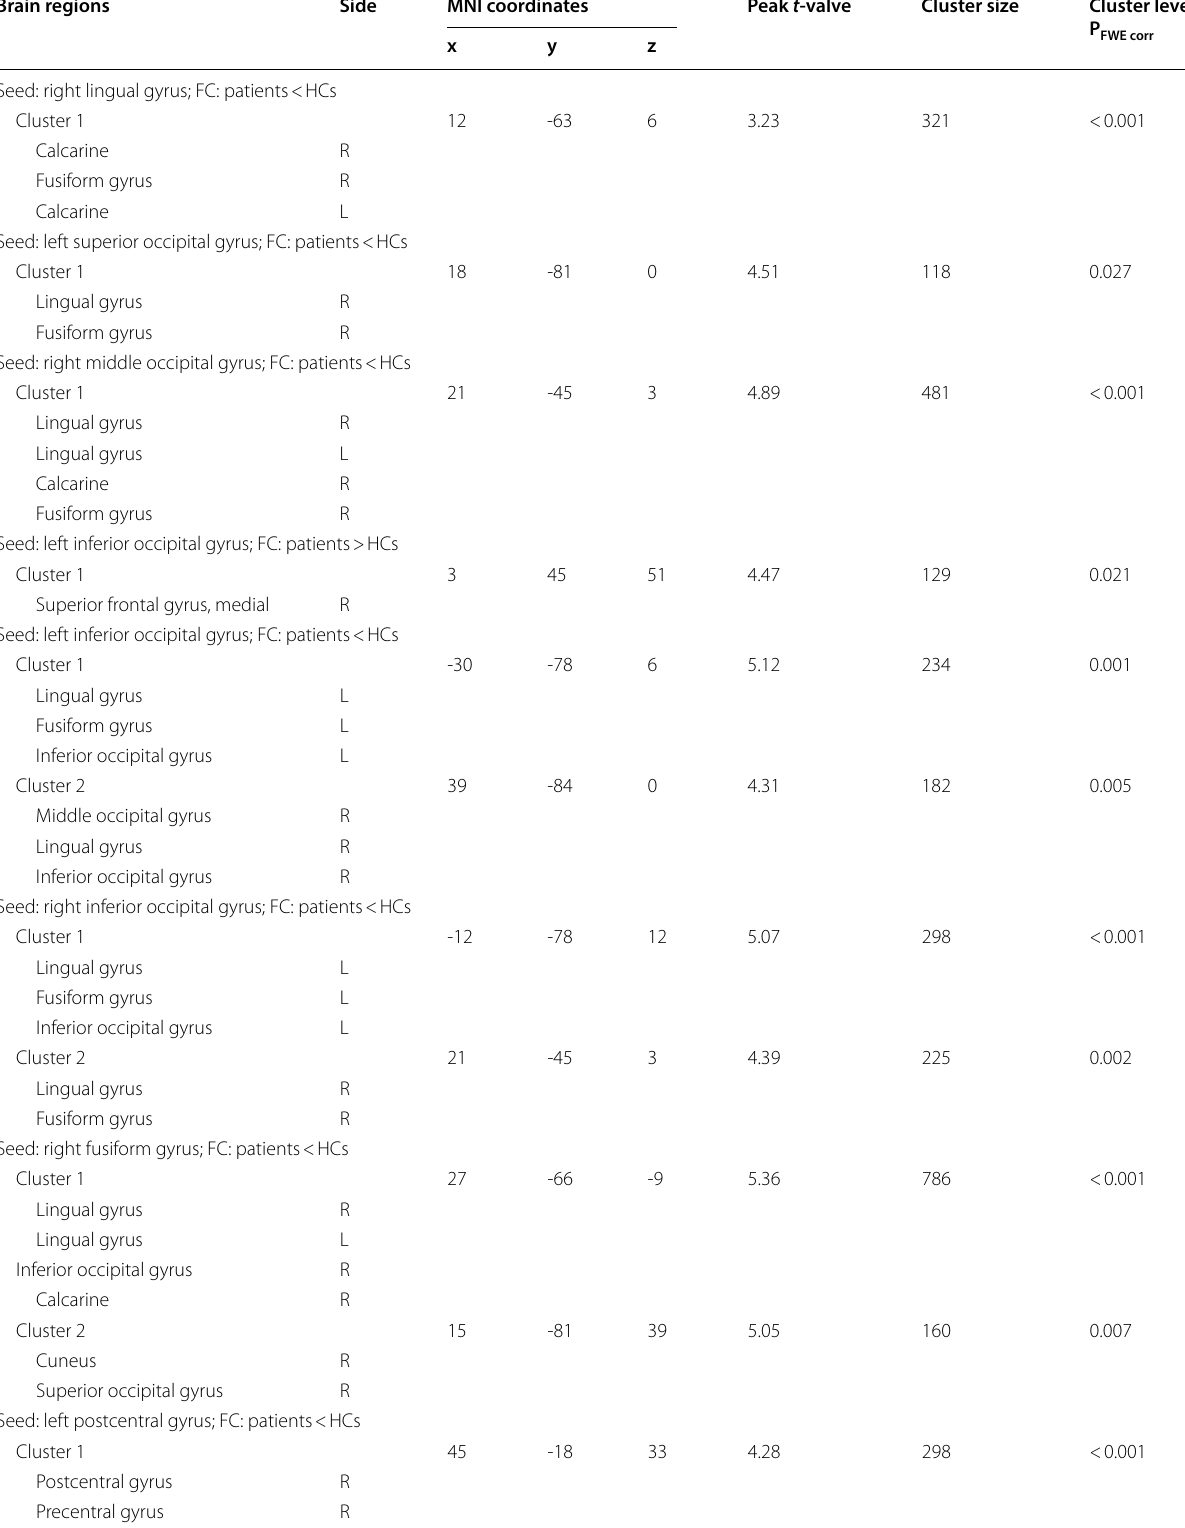
Table 2 Brain regions with aberrant functional connectivity Brain regions Side MNI coordinates Peak t -valve Cluster size Cluster level